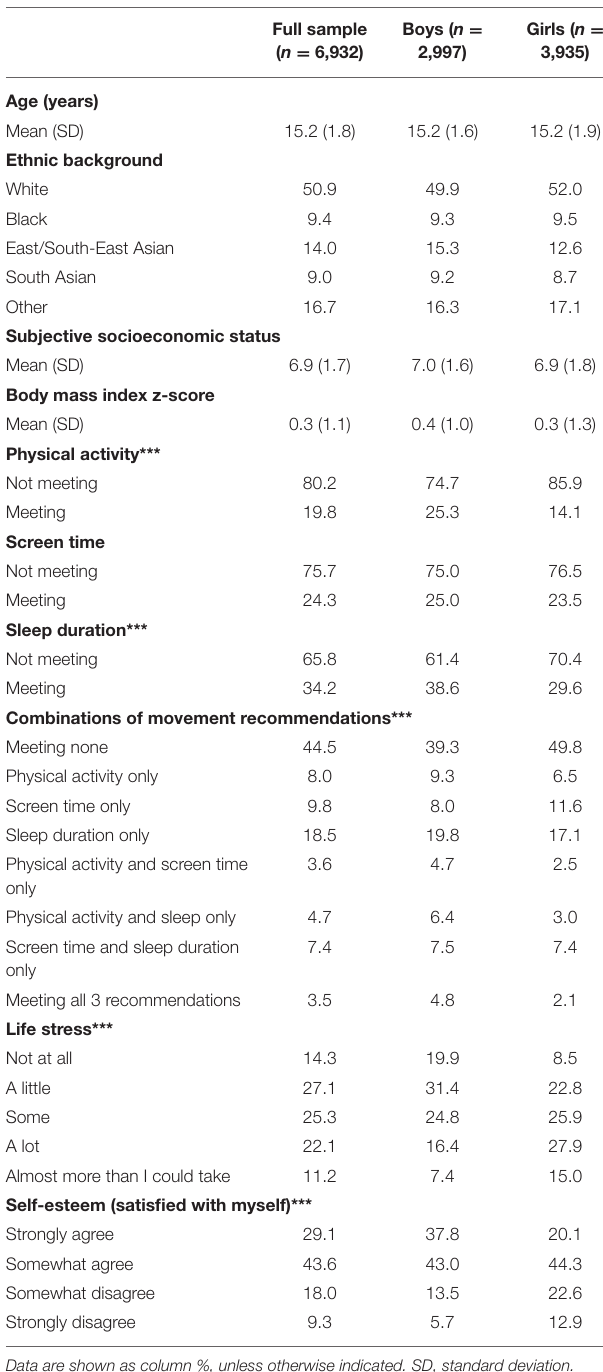
TABLE 1 | Descriptive characteristics of